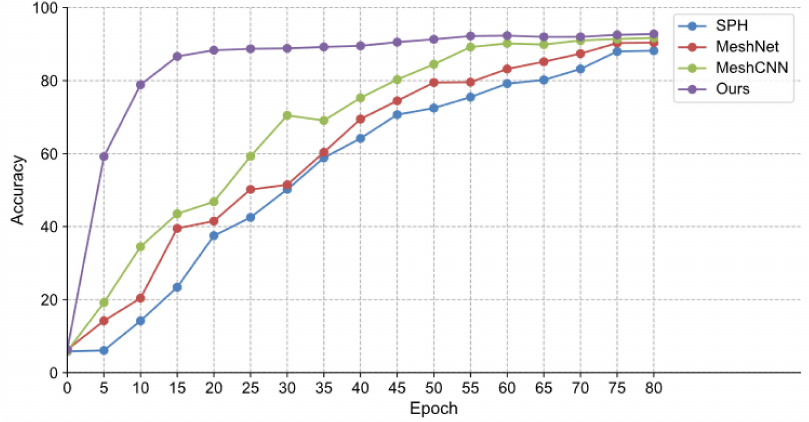
Figure 7. Convergence graph of each method.